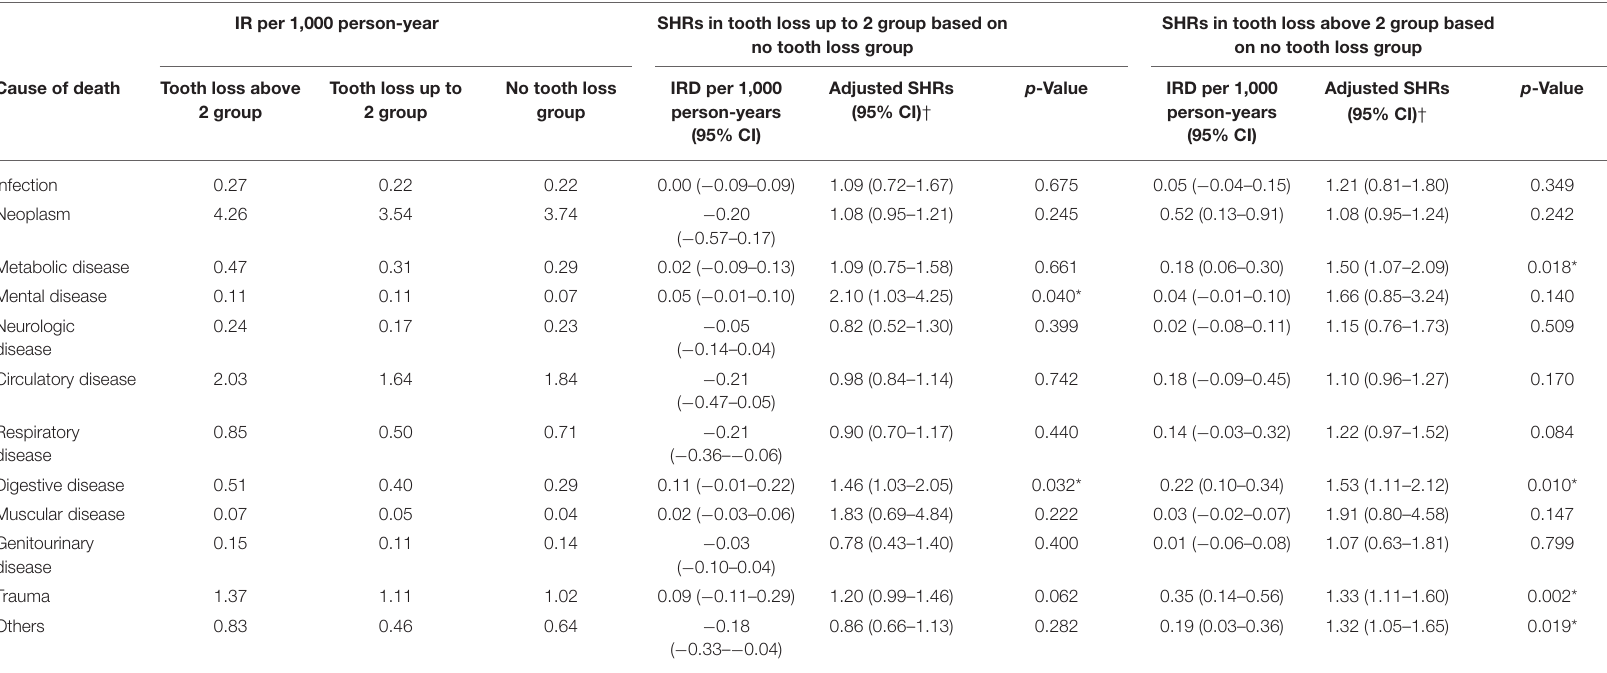
TABLE 4 | Fine and Gray regression analysis in mortality between tooth loss 1 to 2 and tooth loss 0 groups and between tooth loss ≥ 3 and tooth loss 0 groups according to individual cause of